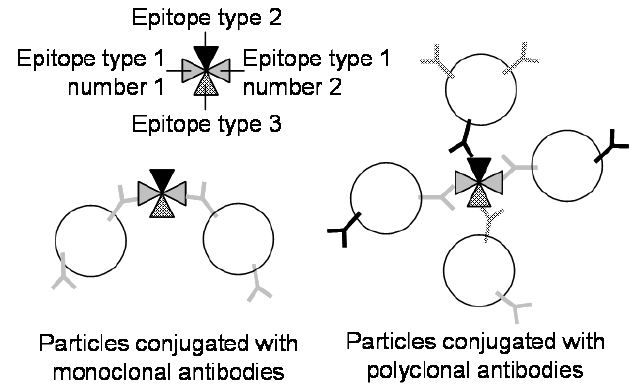
Figure 8. Latex immunoagglutination assay—formation of a doublet or bigger clumps through multiple epitope binding. Reprinted from [47] with permission © American Society of Agricultural and Biological